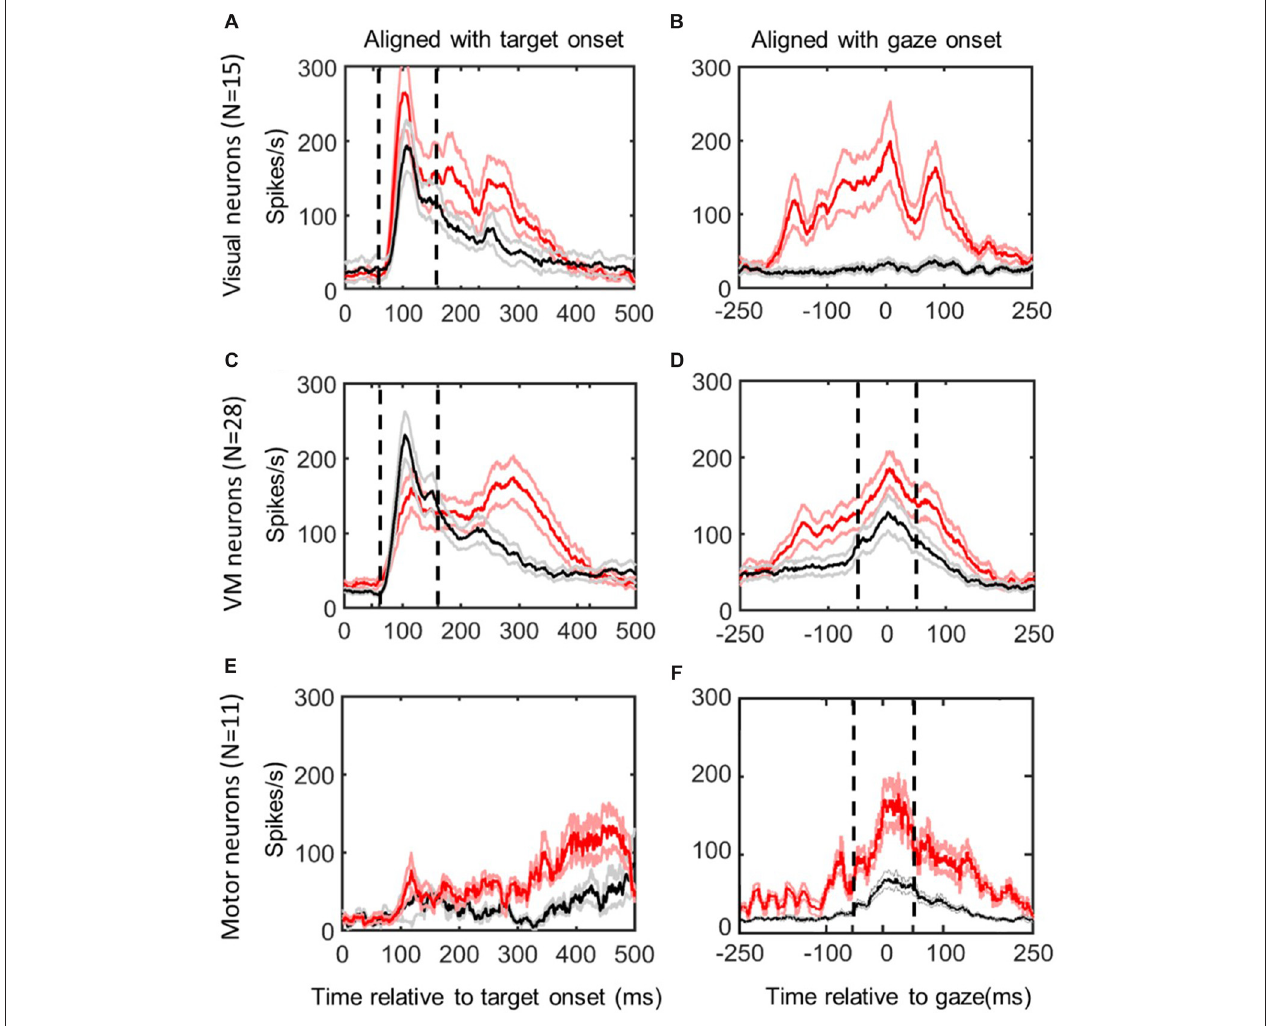
FIGURE 2 | Mean spike density plots/10% confidence intervals from the same neurons in reactive task (red/pink) vs. the memory delay task (black/gray). Data aligned with stimulus onset (left column) and gaze movement (right column). Top row (A,B) : visual neurons, N = 15; middle row (C,D) : visuomotor (VM) neurons ( N = 28); bottom row (E,F) : motor neurons ( N = 11), identified using the memory delay task (Sadeh et al., 2015). Dashed vertical lines indicate the time intervals used for the “fixed window” visual (60–160 ms relative to target presentation) and motor ( − 50 to +50 ms relative to gaze onset) analyses.